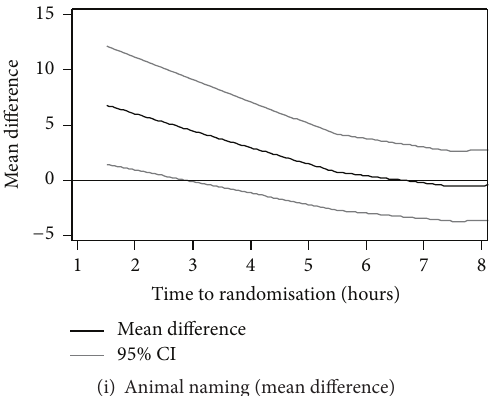
Figure 4: Effect of GTN on outcome by time to enrolment within 8 hours for (a) modified Rankin scale; (b) death; (c) Barthel index; (d) Euro- Qol 5D (EQ-5D) health utility status; (e) Euro-QoL Visual Analogue Scale (EQ-VAS); (f) Zung depression scale; (g) telephone mini-mental state examination; (h) telephone interview of cognition scale, modified (TICS-M); and (i) animal